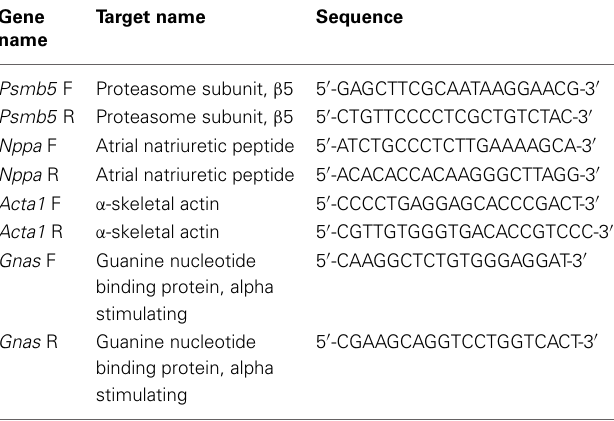
Table 1 | PCR primer names and